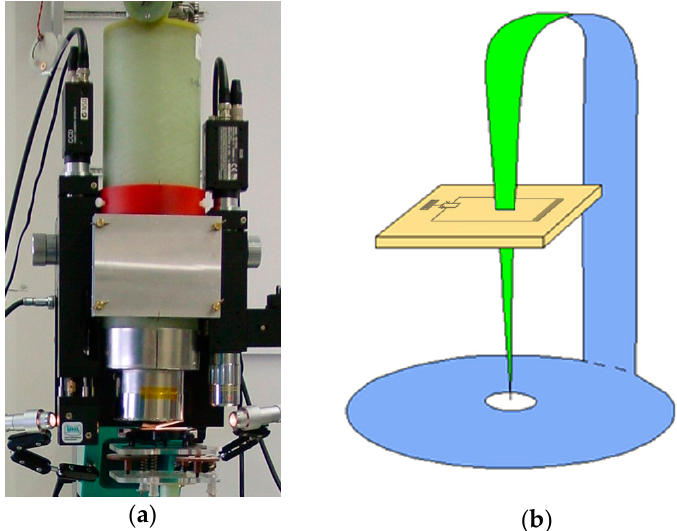
Figure 6. ( a ) Photograph of a high-T c DC SQUID microscope with a fiberglass cryostat that can support 0.8 L of liquid nitrogen; ( b ) Schematic diagram of a high-T c DC SQUID with a magnetic flux antenna made of soft magnetic foil penetrating the directly coupled pick-up loop [47].